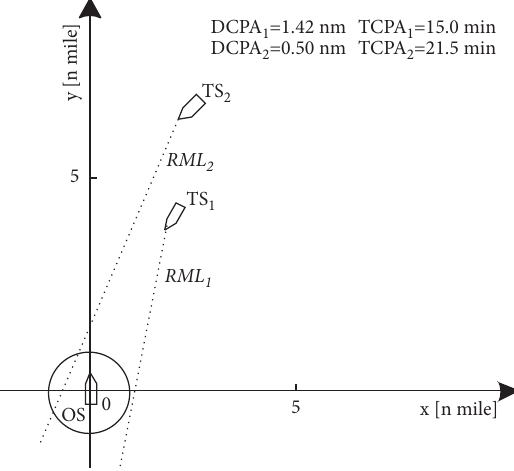
Figure 8: The multiple-vessel encounter Table 4: Scenario II: collision avoidance scheme.